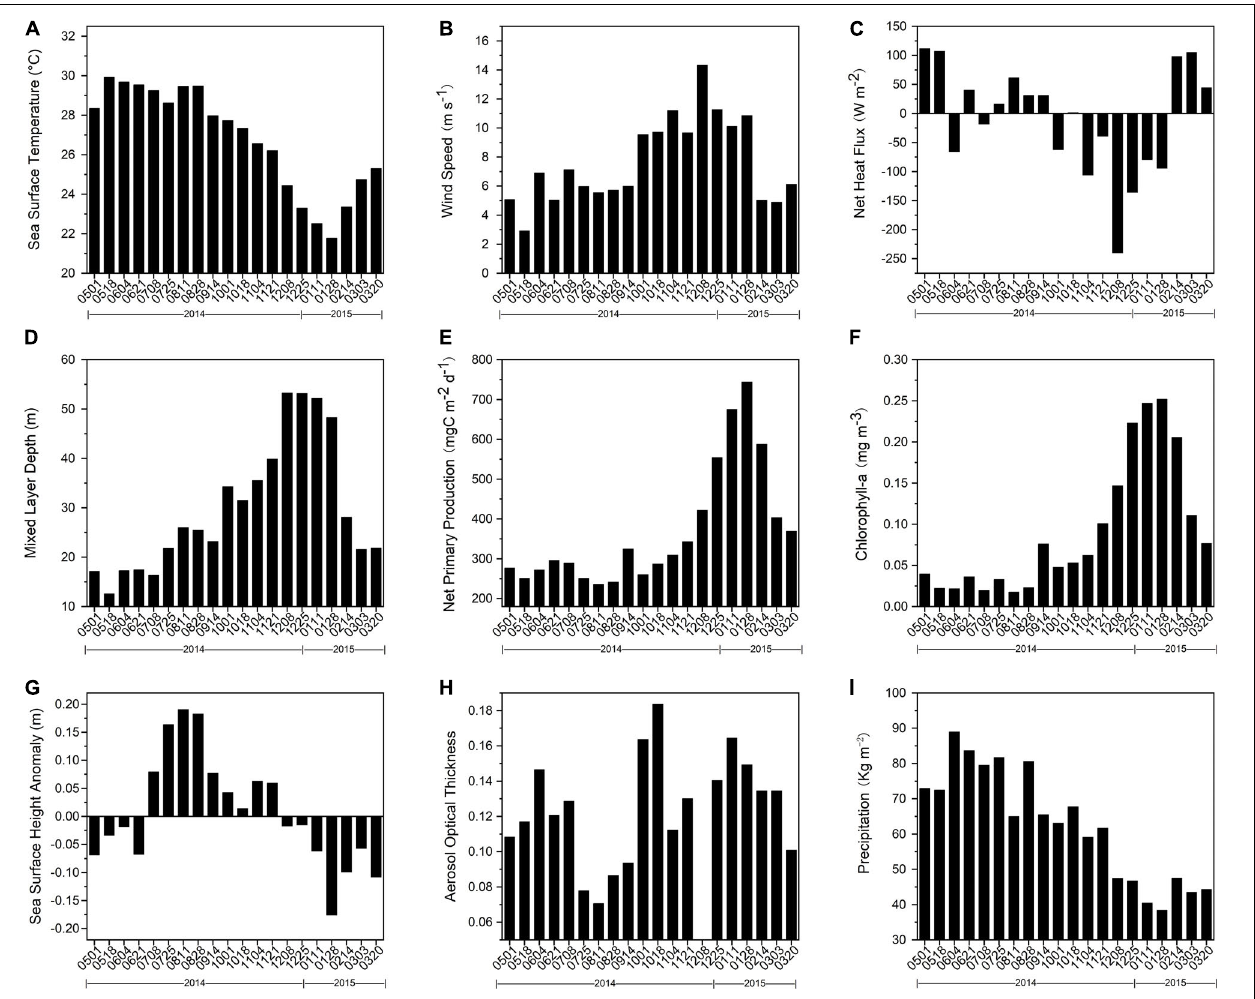
FIGURE 4 | Temporal variations of environmental parameters measured around SCS-N station from May 01, 2014 to April 06, 2015. (A) sea surface temperature, (B) wind speed, (C) net heat flux, (D) mixed-layer depth, (E) net primary productivity, (F) total surface chlorophyll-a concentration (Chlorophyll-a), (G) sea surface height anomaly, (H) aerosol optical thickness, and (I) precipitation.